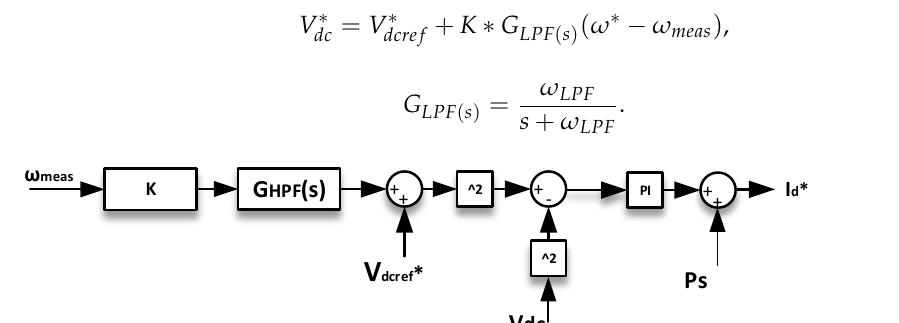
Figure 3. Proposed Virtual Inertia Loop based on HPF.